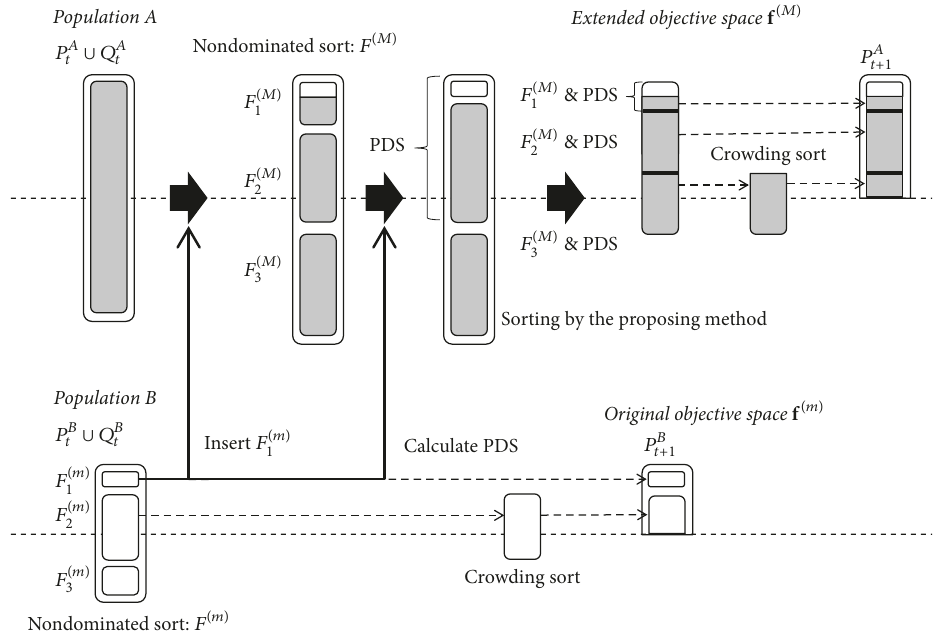
Figure 2: Two evolving populations, concurrent search